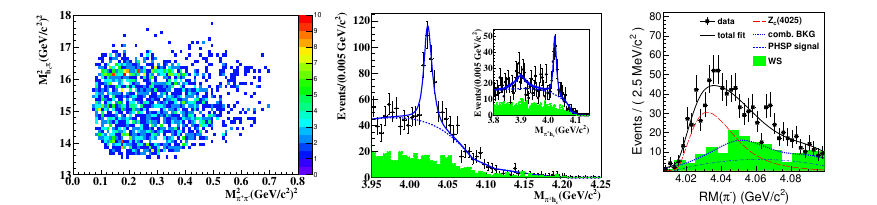
Figure 3. Dalitz plot ( M 2 vs. M 2 ) (left panel) and the fit to the M ( π ± h c ) distribution (middle π + h c π + π − panel) for selected e + e − → π + π − h c events, summed over all energy points; and the fit to the π ∓ recoil √ mass spectrum (right panel) in e + e − → ( D ∗ ¯ D ∗ ) ± π ∓ at s = 4 . 26 GeV.